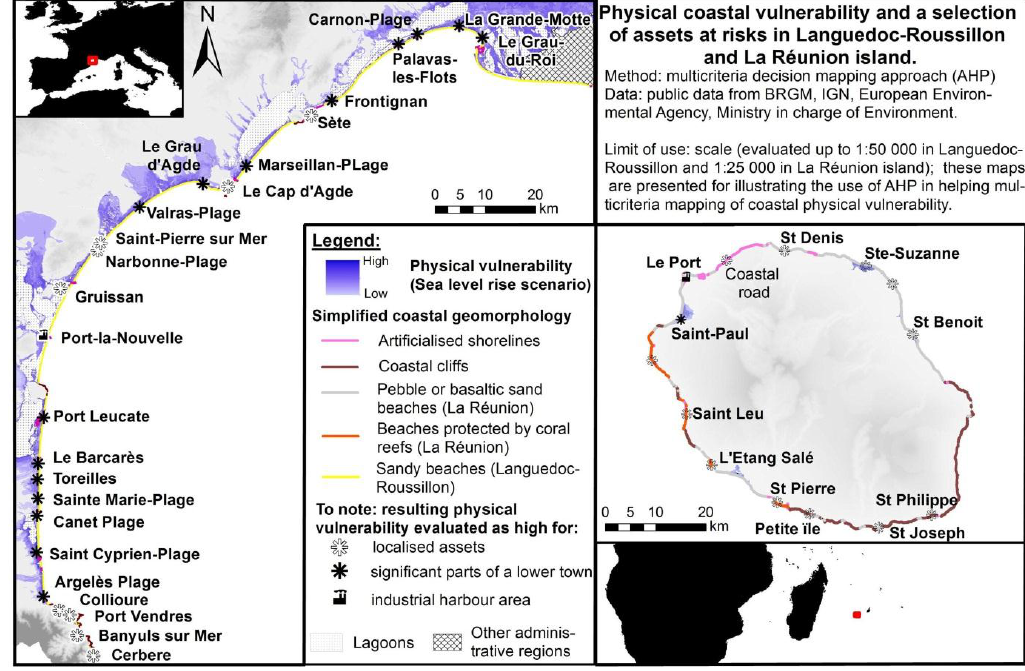
860 Fig. 7. Illustrative example of potential use of the resulting maps: cross tabulation of physical vulnerability with major assets in La R´eunion Figure 7: Illustrative example of potential use of the resulting maps: cross-tabulation of 861 and physical vulnerability with major assets in La Réunion and Languedoc-Roussillon. 862 863